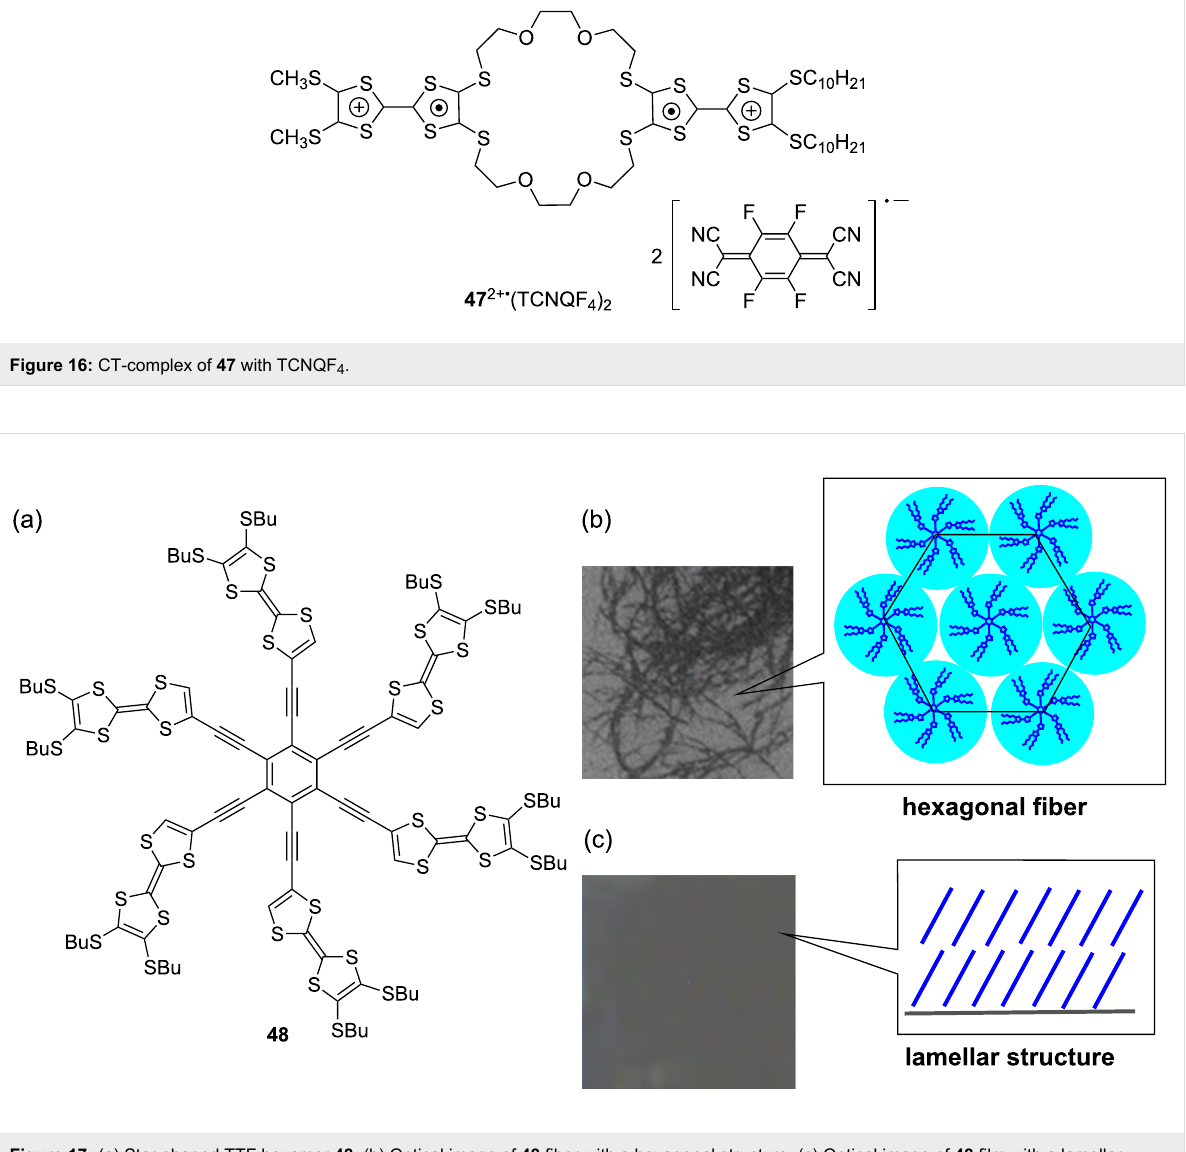
Figure 17: (a) Star-shaped TTF hexamer 48 . (b) Optical image of 48 fiber with a hexagonal structure. (c) Optical image of 48 film with a lamellar structure. Adapted with permission from [22]. Copyright 2007 American Chemical Society.